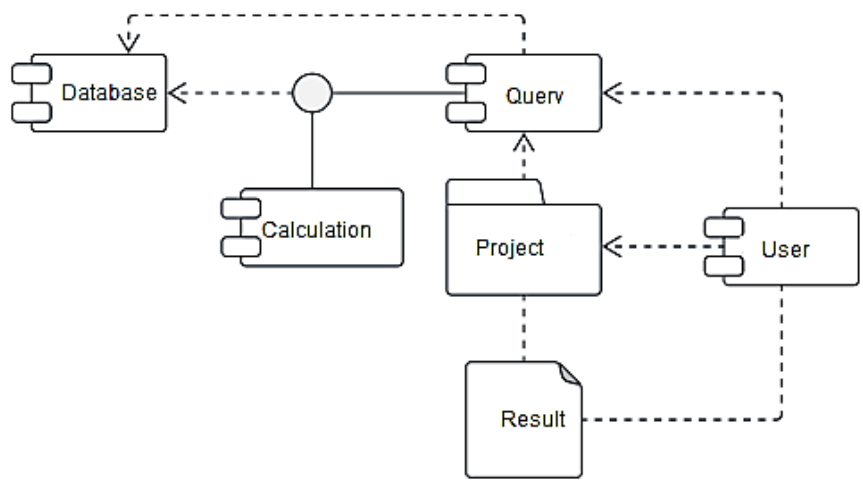
Figure 5. Component diagram.